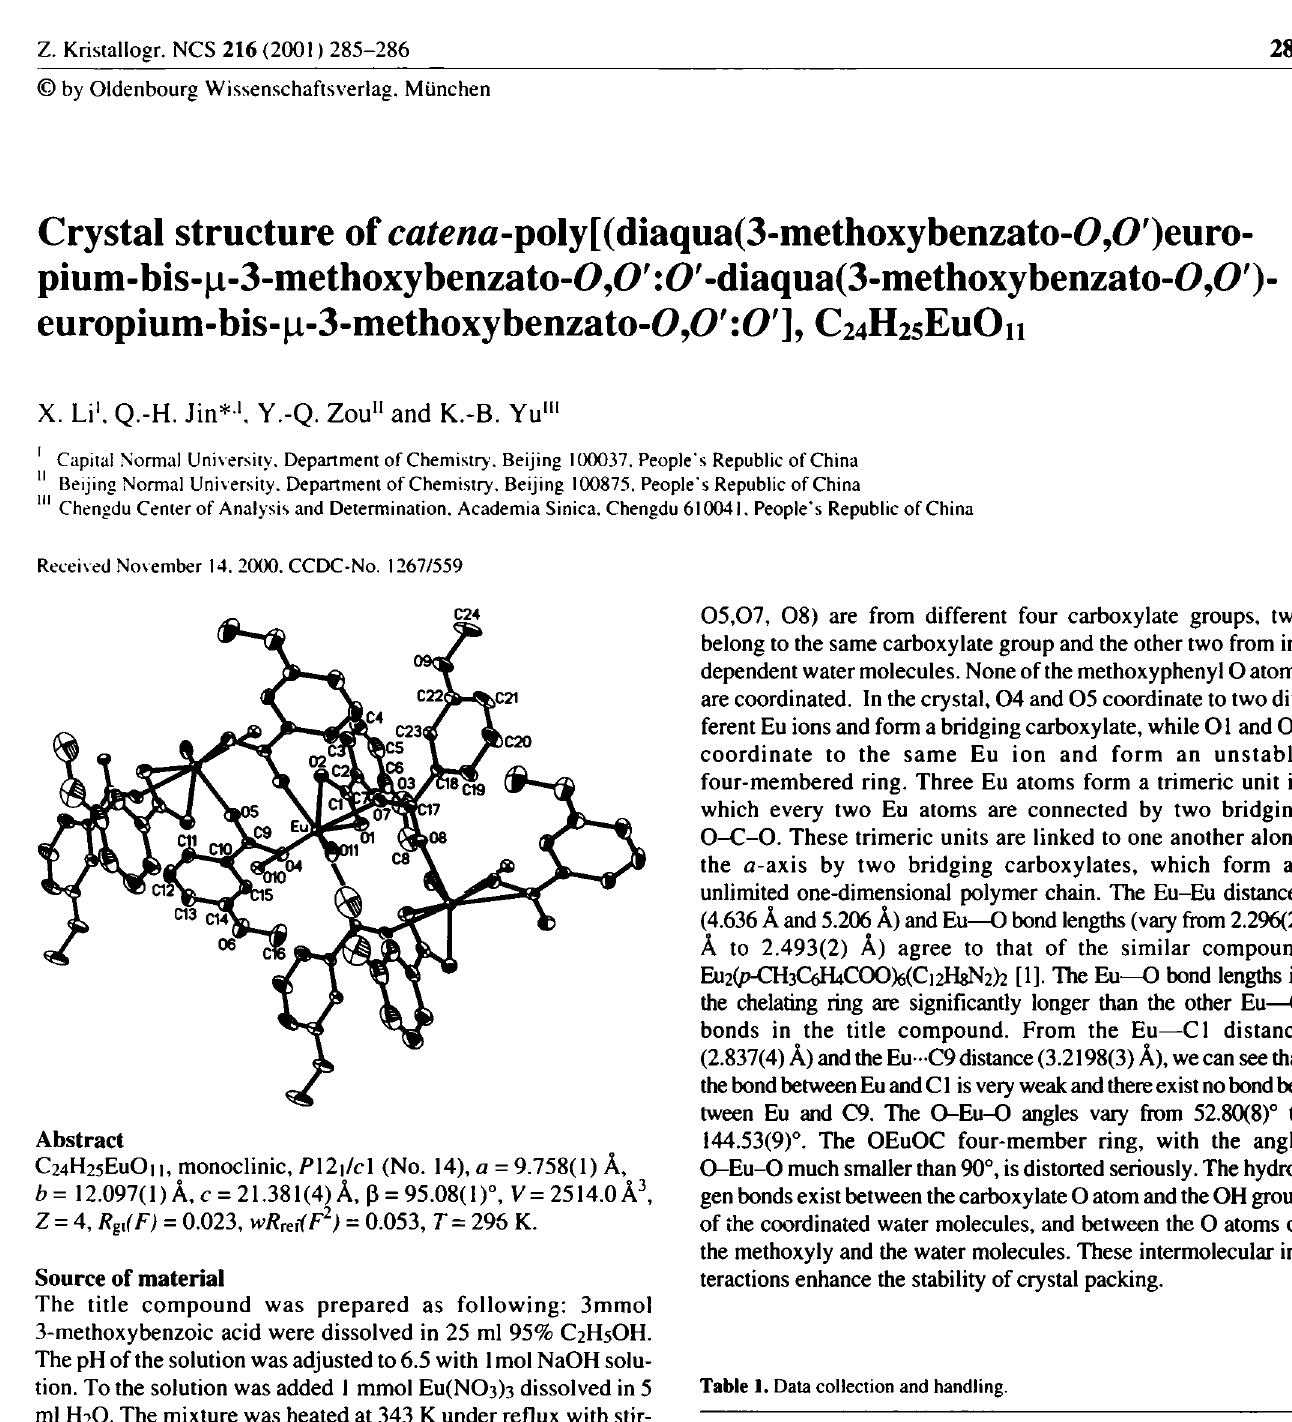
Table 1. Data collection and